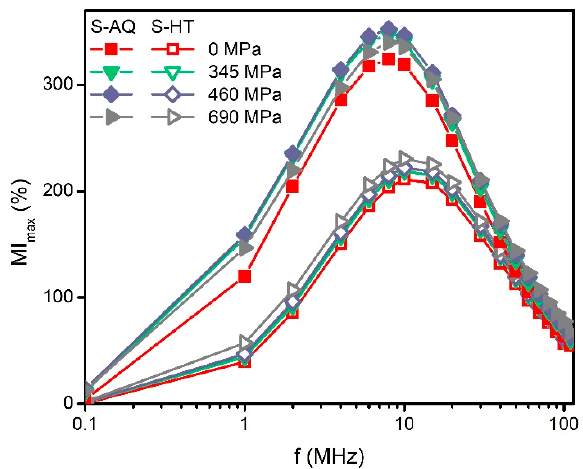
Figure 4. Frequency dependencies of the maximum value of MI, MI max . Dependencies are given for the following values of the tensile stresses: 0, 345, 460 and 690 MPa. Filled symbols correspond to the S-AQ sample, and the empty symbols correspond to the S-HT